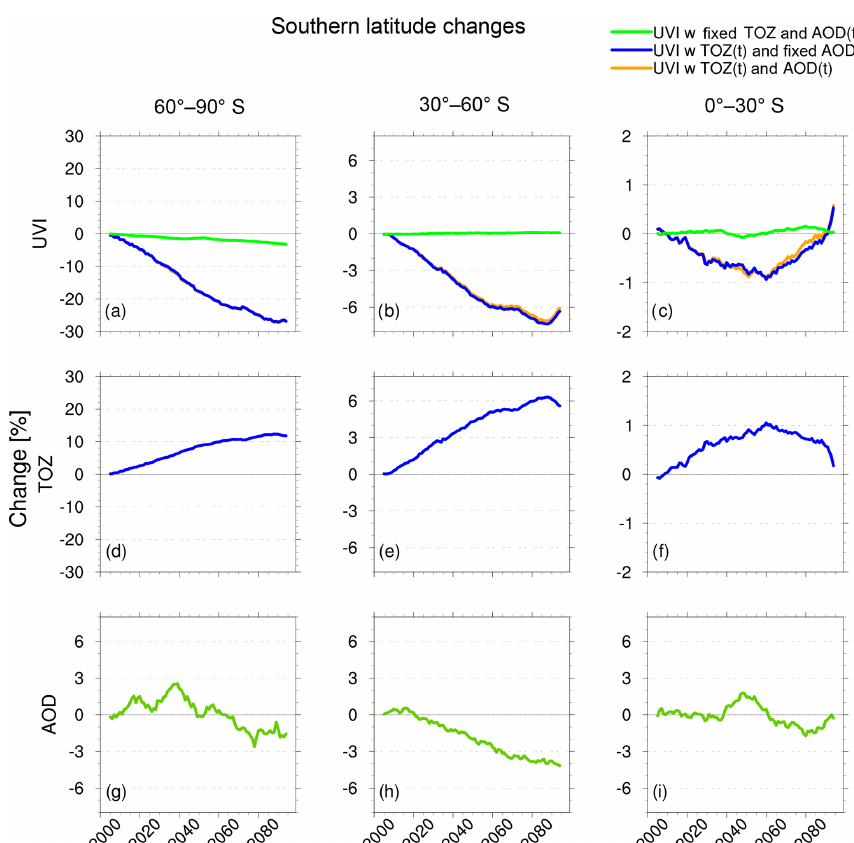
Figure 9. UVI, TOZ and AOD percent change from 2000 to 2010 values in the southern high, middle and low latitudes for the EXP3 experiment. UVI calculated with transient TOZ and AOD fixed at present-day climatological values are in blue. UVI calculated with TOZ fixed at present-day climatological values and AOD variable through the 21st century are in green. UVI calculated with transient TOZ and AOD are in orange. TOZ and AOD are in blue and green